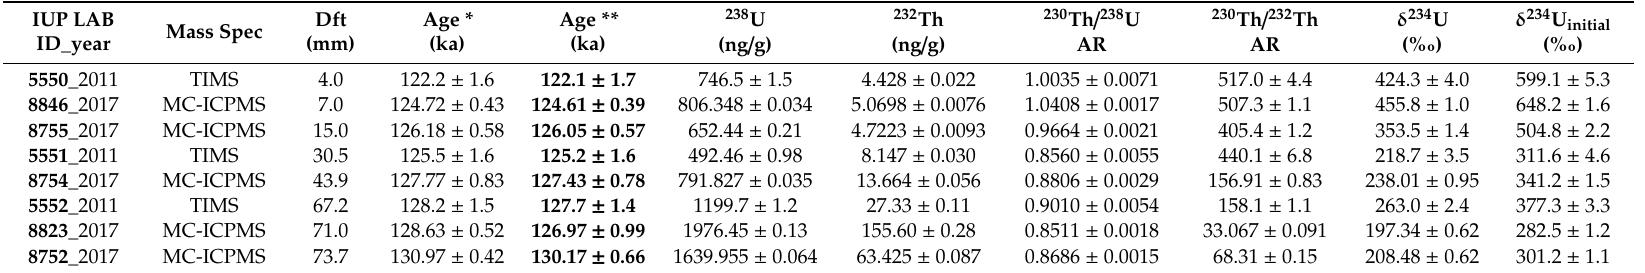
Table 1. Results of U-series analysis for